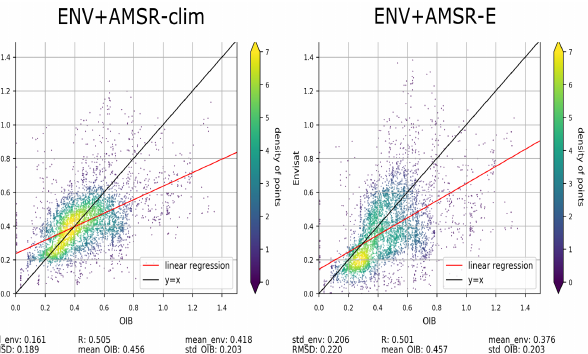
Figure 5. Scatterplots comparing the calibrated envisat total freeboards (using the 2 AMSR snow depth datasets) with all the data of the 6 OIB missions.